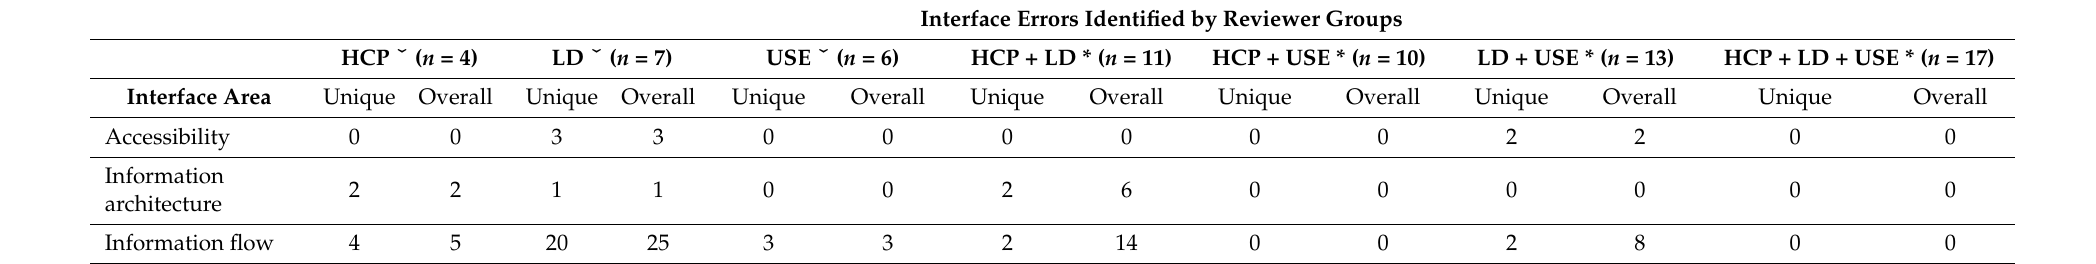
Table A4. Exclusive and mutually inclusive interface errors mapped across and between evaluator